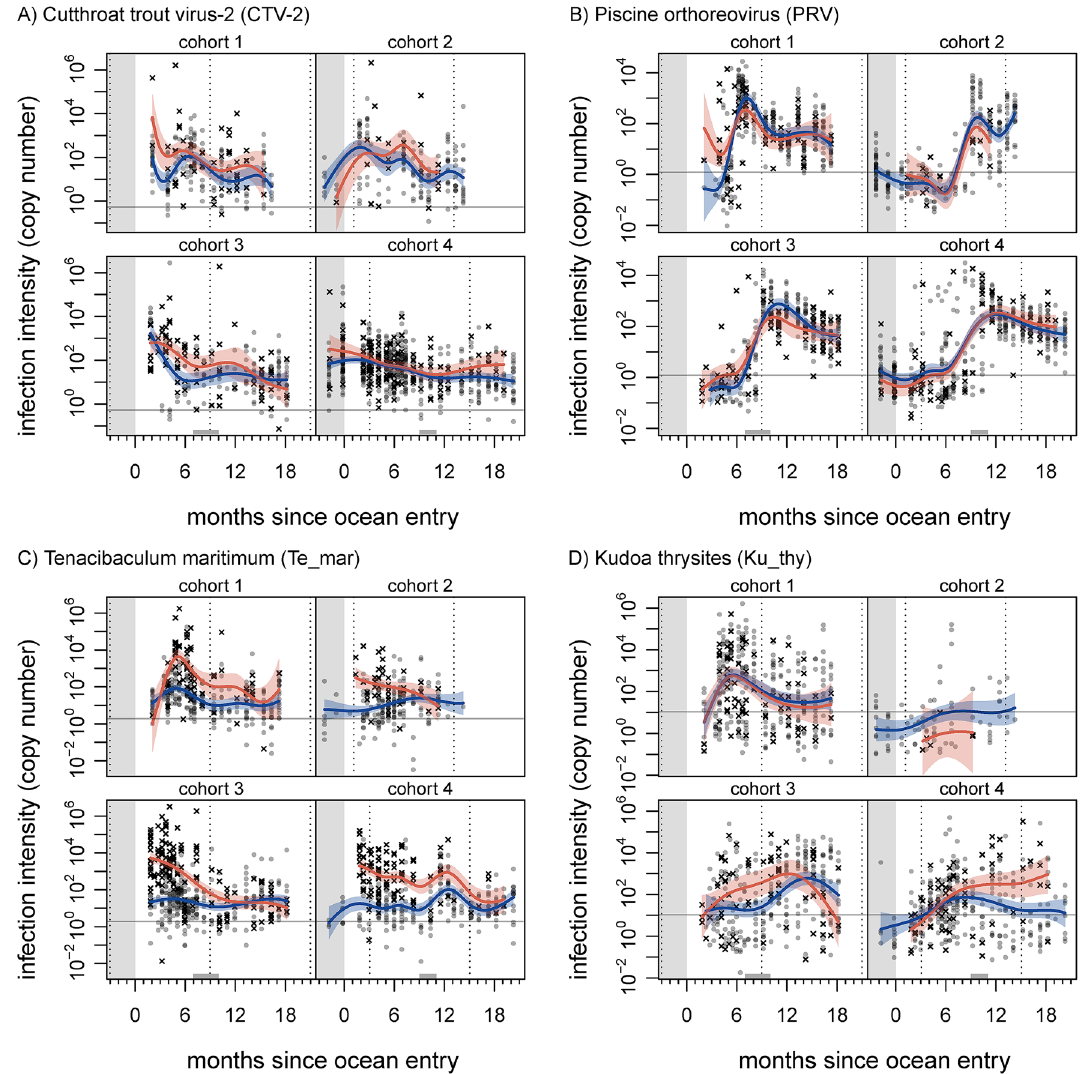
Figure 3. Agent intensity of Cutthroat trout virus (CTV-2; A ), Piscine orthoreovirus (PRV; B ), Tenacibaculum maritimum (Te_mar; C ), and Kudoa thyrsites (Ku_thy; D ) in farmed Atlantic salmon throughout four production cycles. Grey circles represent live fish, and black X’s represent dead/dying fish. Curves indicate mean predictions from a generalised additive model; blue and red correspond to live and dead/dying fish, respectively (shaded areas show 95% confidence regions). Left-hand grey region indicates freshwater hatchery residence, grey regions on x-axis indicate period of transfer to another site, and vertical dotted lines correspond to January 1st. Horizontal grey line indicates limit of detection (yielding ≈90% true positive rate) for respective qPCR assay run in duplicate. Note log